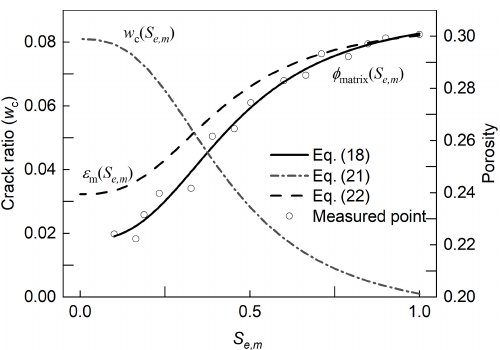
Figure 10. Fitted shrinkage curve (solid line) and modeled porosity variation of matrix (dashed line) and crack domains (dashed–dotted line).